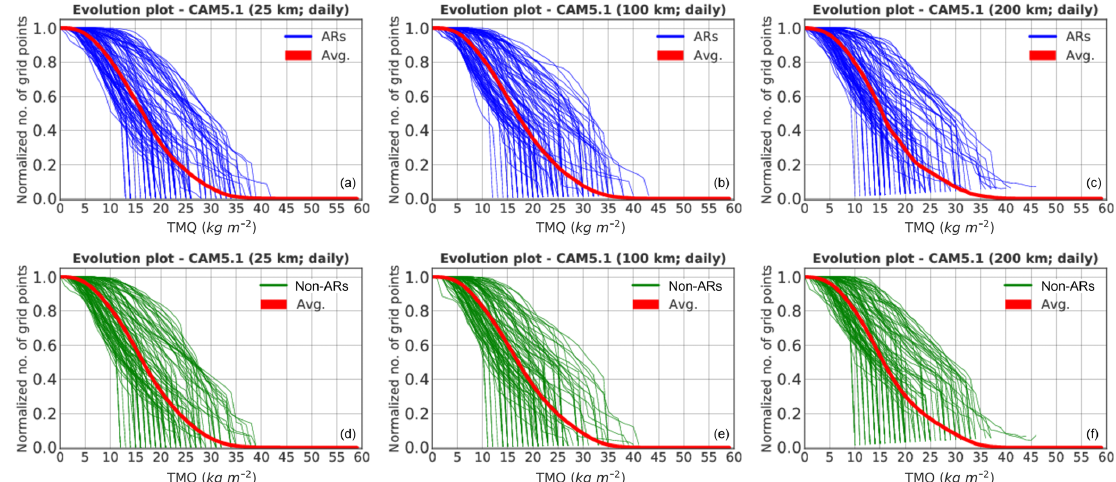
Figure A1. Normalized evolution plots of averaged (red curves) and 100 arbitrarily selected topological feature descriptors of ARs (blue curves; a, b, c ) and non-ARs (green curves; d, e, f ) for daily temporal resolution and 25km (a, d) , 100km (b, e) and 200km (c, f) spatial resolutions of the CAM5.1 simulation data. The plots illustrate the relationship of topological descriptor variation versus average. They show the topological representation of both AR and non-AR events for each resolution of CAM5.1 model